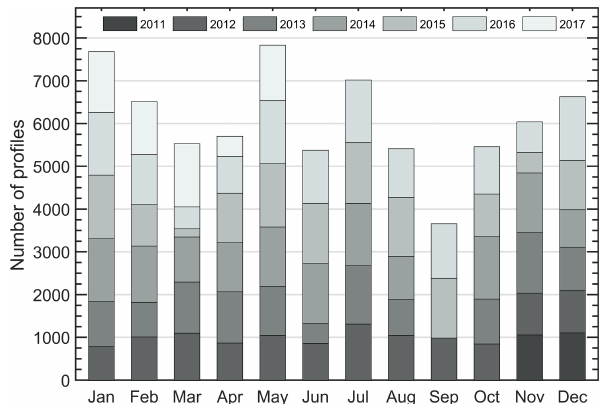
Figure 1. Distribution of the monthly total number of radar return echo-power profiles that are available from vertical beam in low mode, collected for the period November 2011–May 2017.